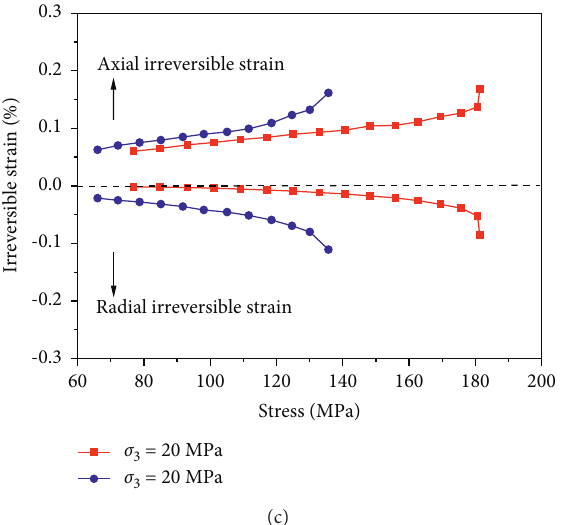
Figure 4: Relationship between irreversible strains and axial stress (blue denotes saturated phyllite and red denotes dry phyllite; σ confining